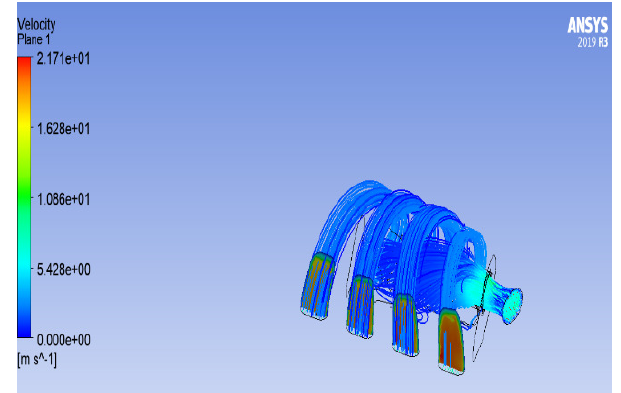
Fig. 6. Mesh resolution of 3 for an inlet velocity of 50m/s